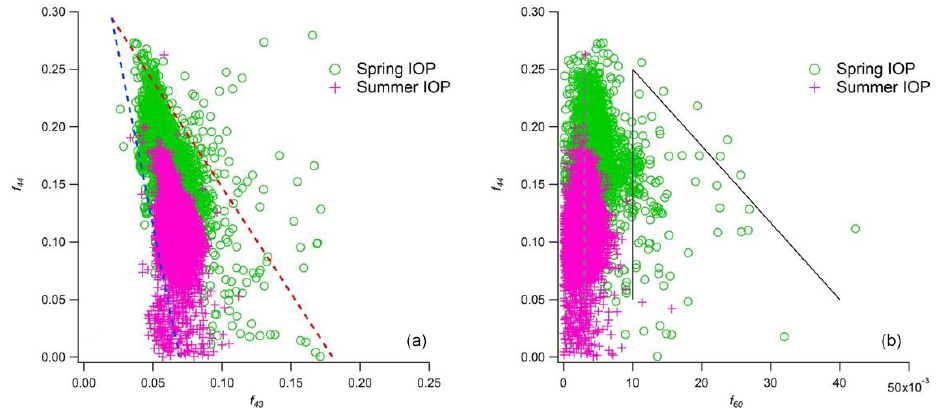
Figure 5. f 44 as a function of (a) f 43 and (b) f 60 for OA observed during spring and summer IOPs. f 44 represents the ratio of signal at m/z 44 (mainly CO + ) to the total organic signal, f 43 refers to ratio of total m/z 43 (mainly C 3 H + 2 and f 60 refers to the ratio of m/z 60 (mainly C 2 H 4 O + ) to the total organic 2